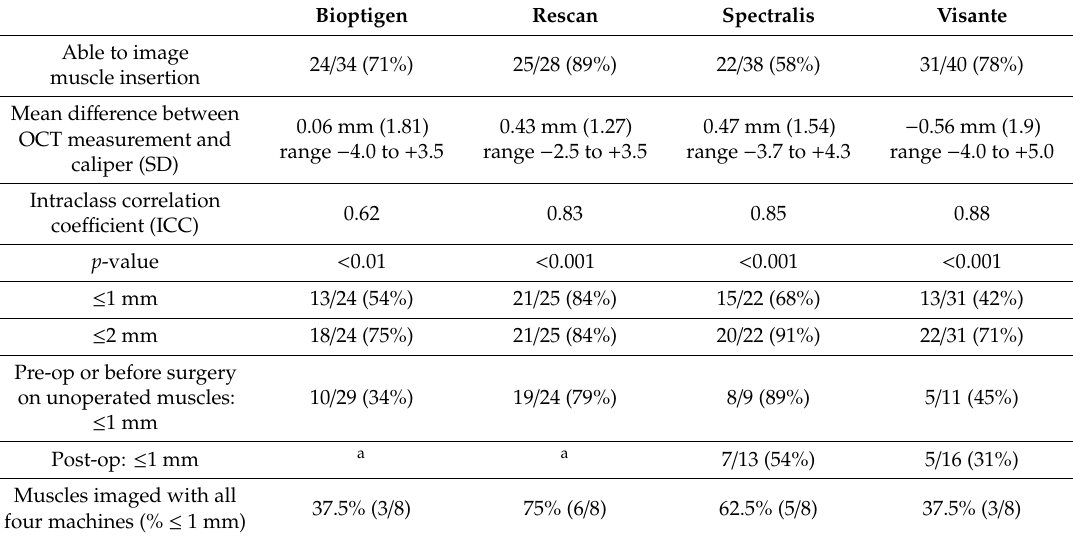
Table 1. Anterior segment optical coherence tomography measurement results.